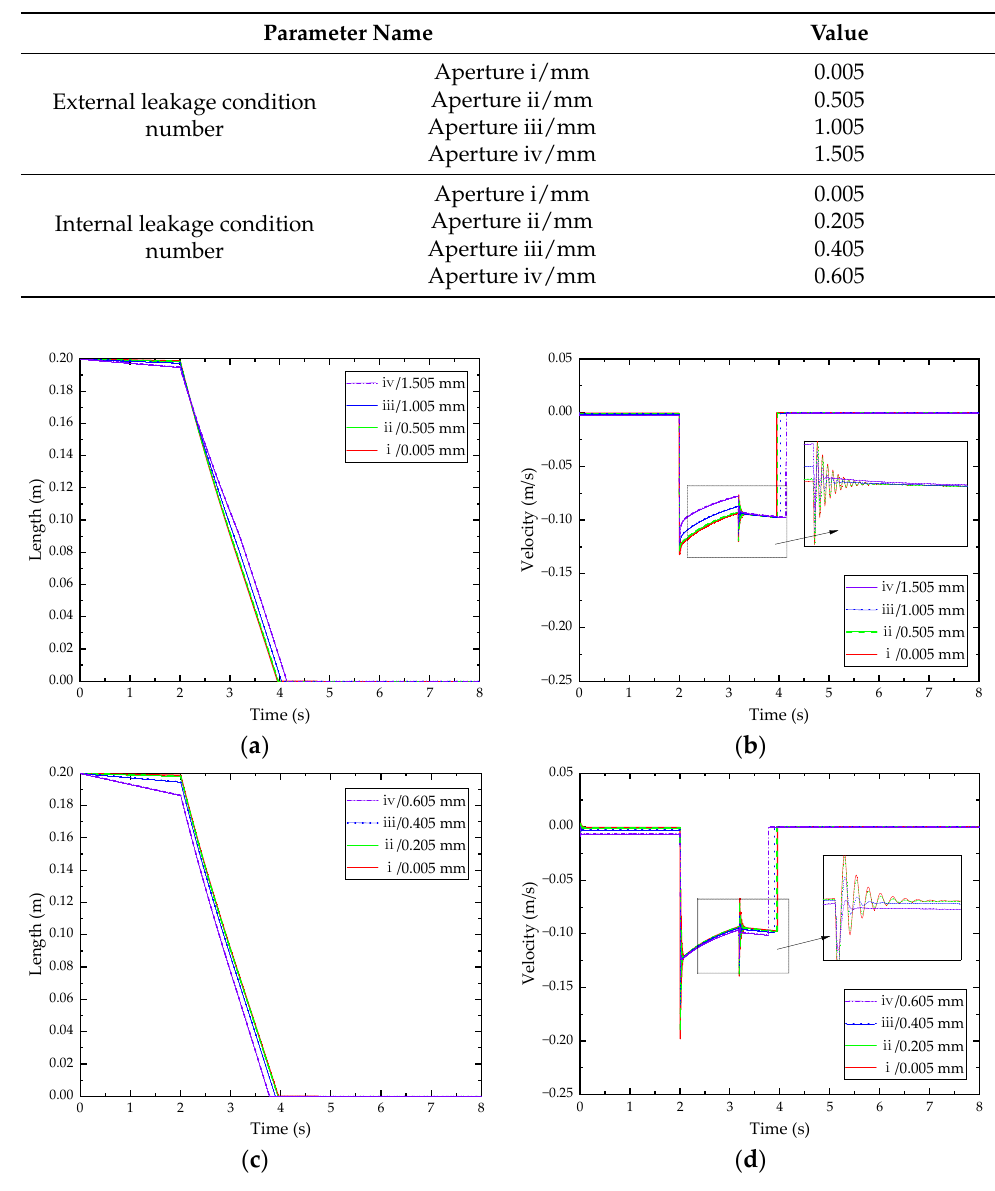
Figure 12. Effect of actuator external leakage: ( a ) Piston displacement; ( b ) Piston Velocity; Effect of actuator internal leakage: ( c ) Piston displacement; ( d ) Piston Velocity.